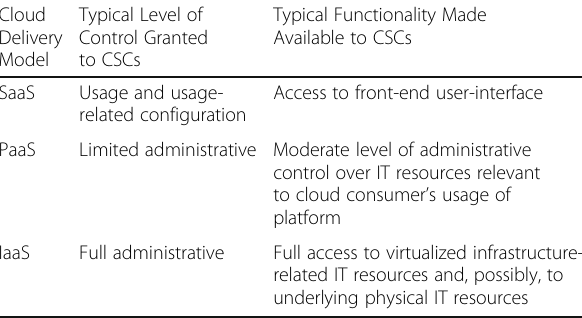
Table 1 A comparison of typical cloud delivery model control levels